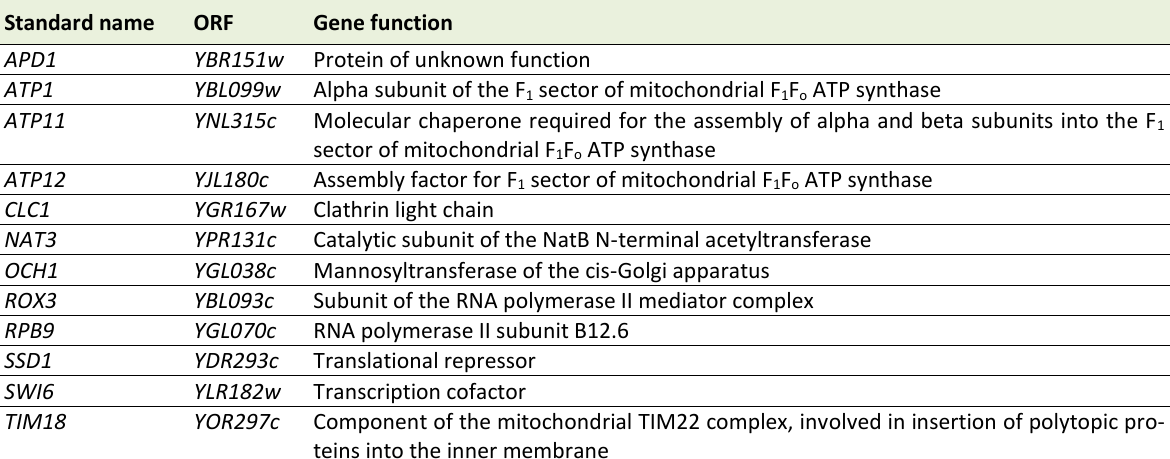
TABLE 2. Mutants that were unable to grow on EtBr-containing medium. Descriptions of gene functions were taken from the Saccharo- myces Genome Database [36] with some manual